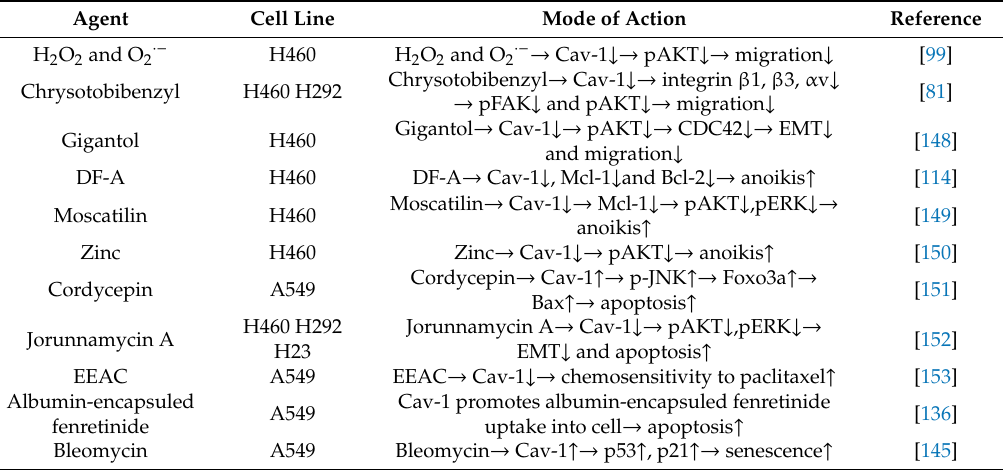
Table 2. Various Cav-1-targeted approaches to suppressing NSCLC